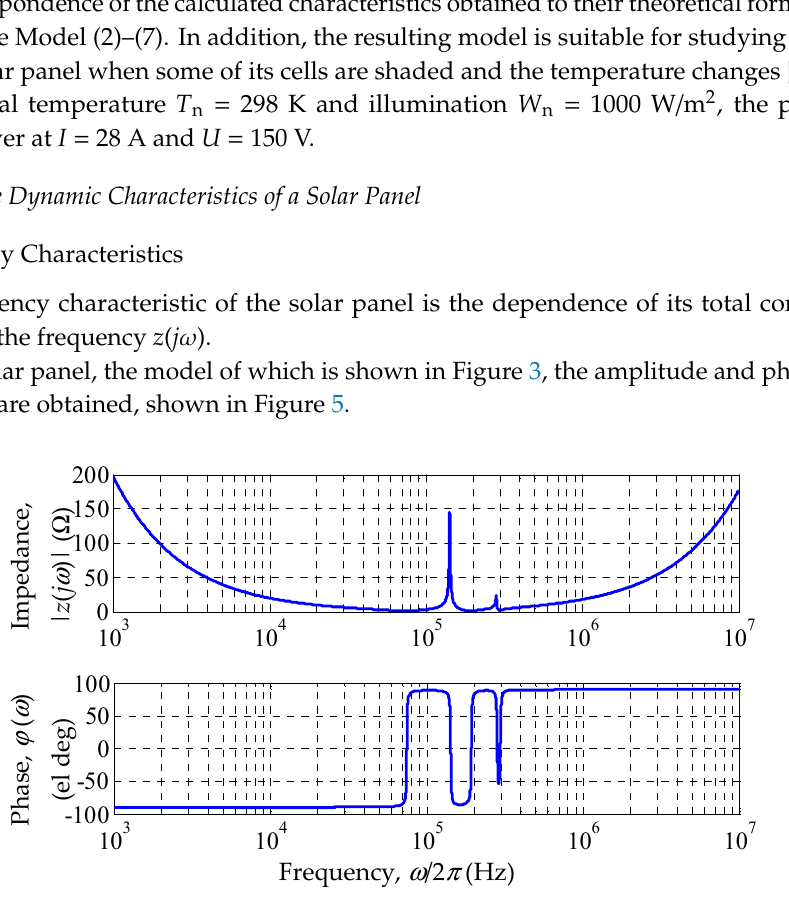
Figure 5. Frequency response of the solar panel.